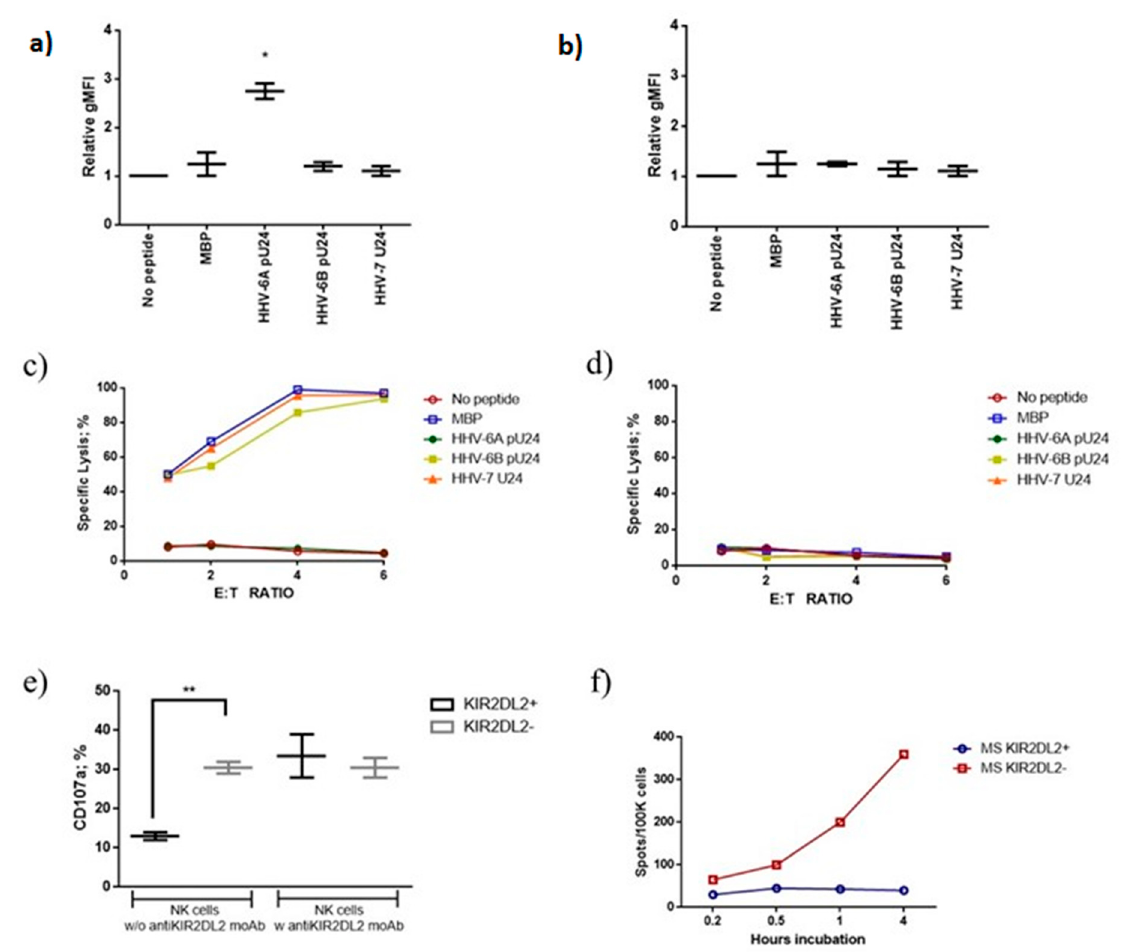
Figure 5. Expression of ( a ) HLA ‐ C1 in 721.221 ‐ ICP47 ‐ C1 and ( b ) HLA ‐ A2 in 721.221 ‐ ICP47 ‐ A2 after MBP, pU24 ‐ 6A, pU24 ‐ 6B or U24 ‐ 7 treatment. gMFI: The data are presented as mean ± SD. * significant p value, Student t test. ( c ) 721.221 ‐ ICP47 ‐ C1 or ( d ) 721.221 ‐ ICP47 ‐ A2 cells were incubated with the different peptides and co ‐ cultured with KIR2DL2 positive NK cells from MS patients. The cytolytic activity of KIR2DL2 positive NK cells was tested by calcein acetoxymethyl ester (CAM) cytotoxicity assay. The data are presented as mean. ( e ) NK cells from MS patients were co ‐ cultured with 721.221 ‐ ICP47 ‐ C1 cells incubated with pU24 ‐ 6A. The expression of CD107a, marker of NK cell activation, was evaluated in the absence (w/o) or presence (w) anti ‐ KIR2DL2 antibody. The data are presented as mean ± SD. * significant p value, one way ANOVA for multiple comparison corrected for multiple comparisons, by Bonferroni’s correction. ** significant p value, Fisher exact test. ( f ) Granzime B Fluorospot assay on KIR2DL2 positive and negative NK cells from